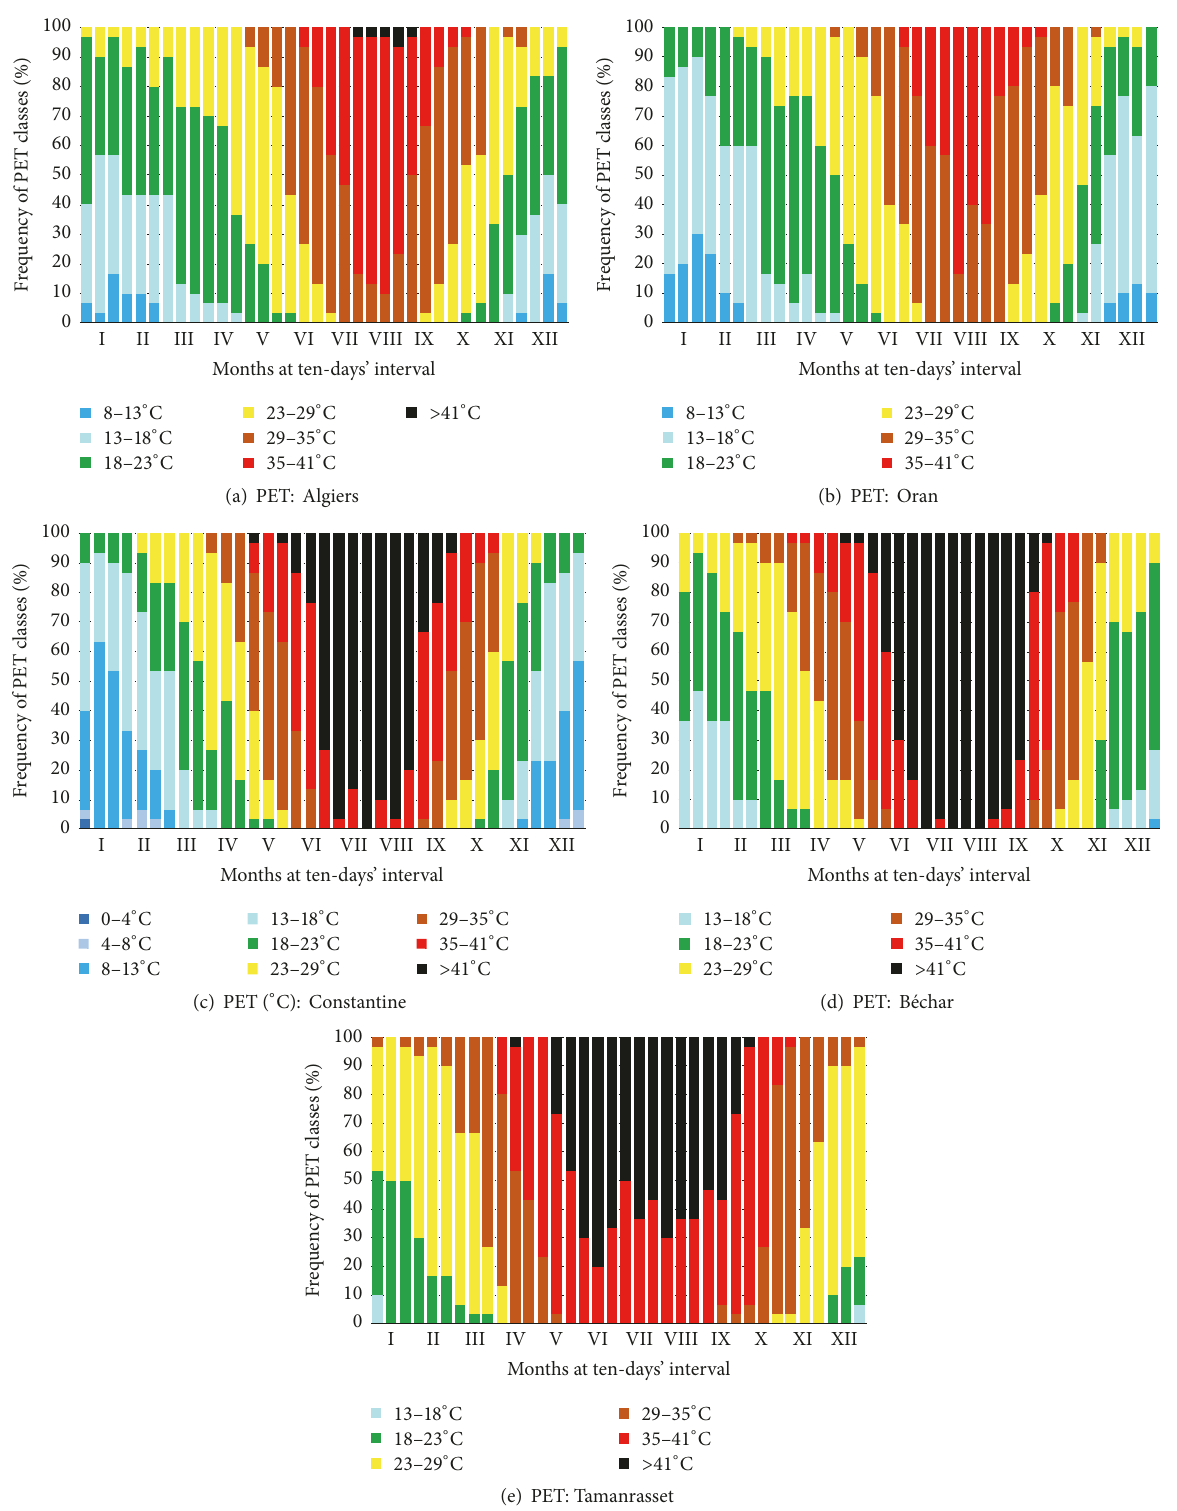
Figure 5: Bioclimatic diagram for the 5 cities for the period of 1986–2015; frequencies (%) of the nine PET classes for 10-day period of the mean